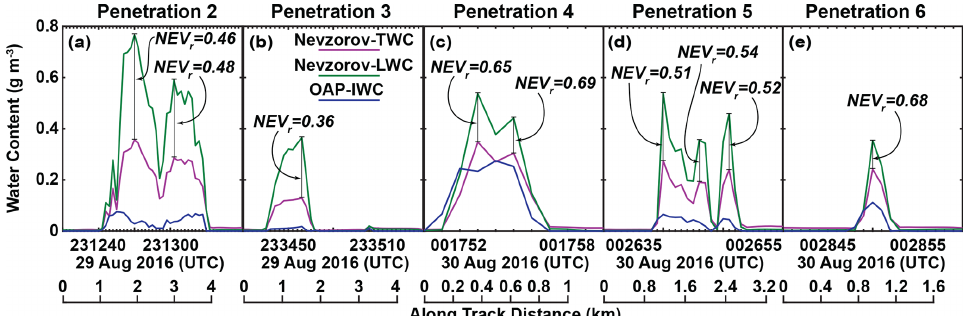
Figure 16. UWKA water content data for (a–e) penetrations 2–6 (Fig. 1d, Table 2). TWC from the Nevzorov TWC probe (magenta), LWC from the Nevzorov LWC probe (green), and IWC derived from OAP size distributions using a mass–diameter relation (blue). Ratio of TWC from Nevzorov TWC probe to LWC from Nevzorov LWC probe (NEV r ) shown at selected times. Along-track distance for each penetration shown at